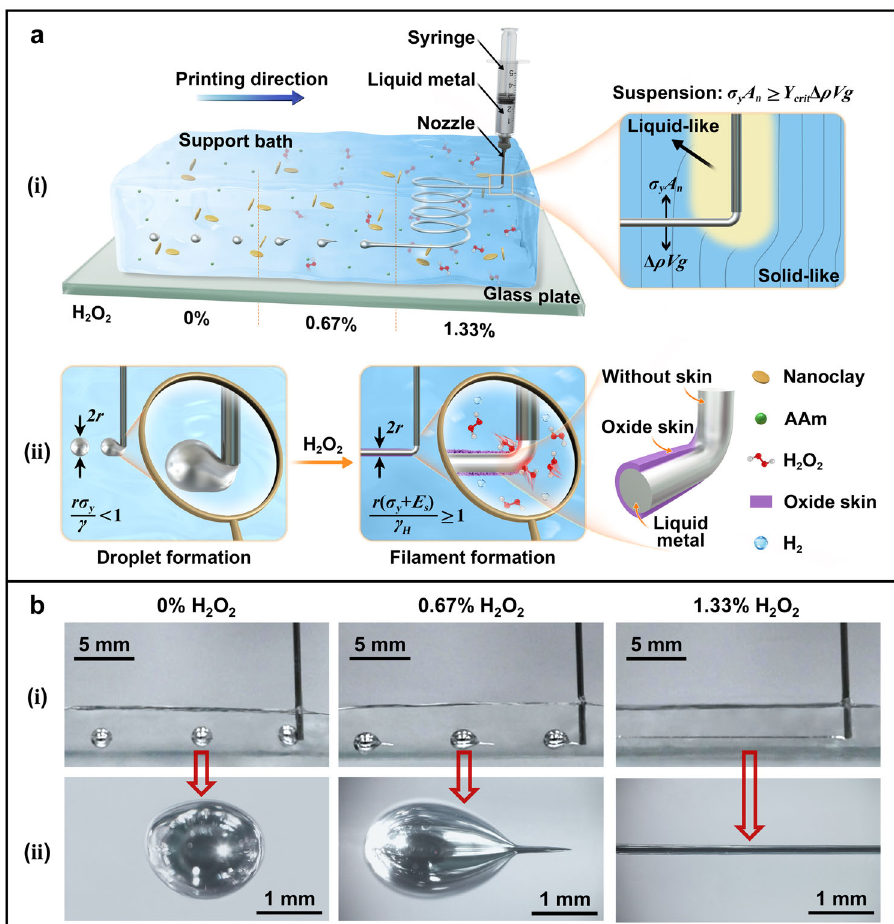
Fig. 1 The mechanism of printing liquid metal dangling structures in the AAm/nanoclay support bath. a Schematic of liquid metal suspension printing in AAm/nanoclay support bath with hydrogen peroxide. b In fl uence of hydrogen peroxide concentration on the printed fi laments. (i) and (ii) show photographs and optical microscope images of a linear con fi guration of liquid metal printed in the support bath with different hydrogen peroxide concentrations,